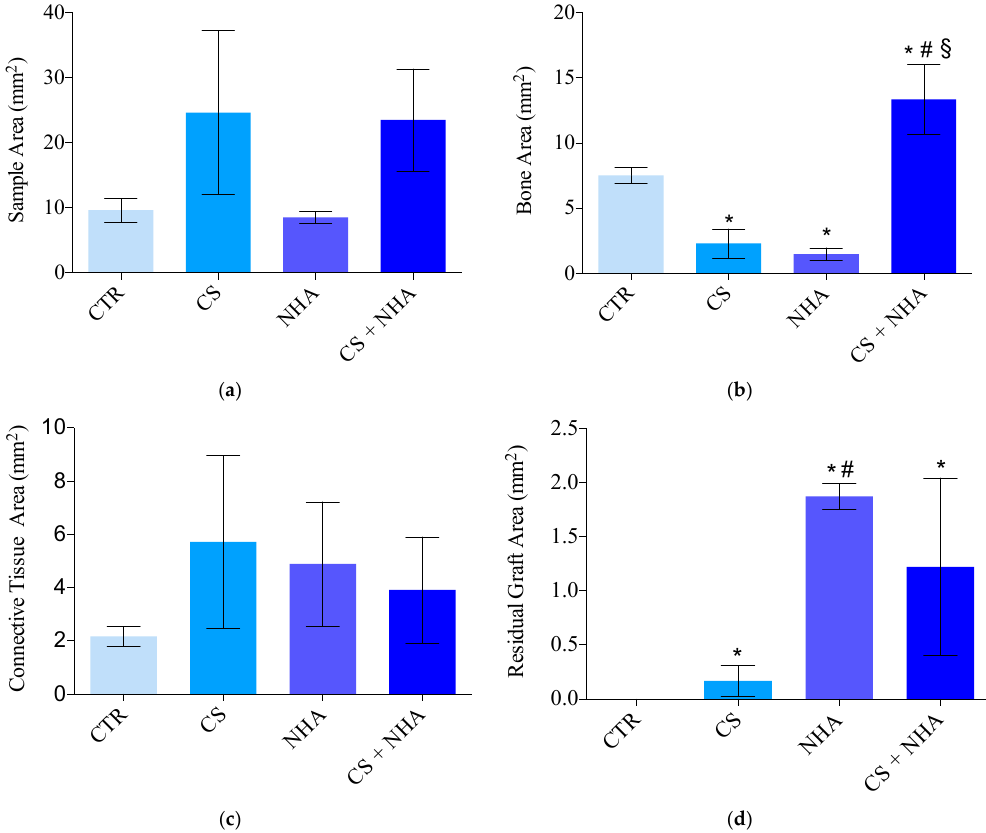
Figure 8. Sample area in mm 2 ( a ), bone area in mm 2 ( b ), connective tissue area in mm 2 ( c ), residual graft area in mm 2 ( d ). CTR: Control; CS: Calcium sulphate; NHA: Sintered nanohydroxyapatite; CS + NHA: Calcium sulphate plus sintered nanohydroxyapatite; *: Significantly different compared to the control group; #: Significantly different compared to the calcium sulphate group; §: Significantly different compared to the NHA group.